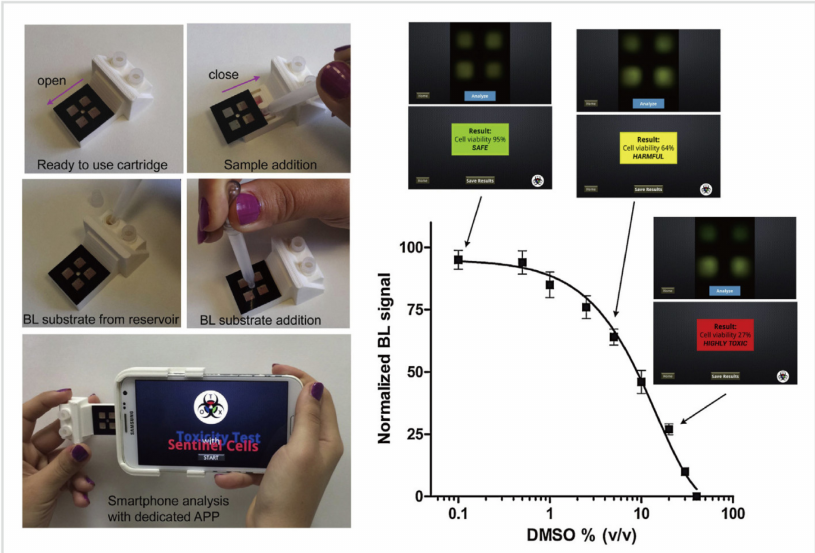
Figure 6. A smartphone-based bioluminescence (BL) whole-cell toxicity biosensor for on-field detection of toxicants; several easy steps required to carry out the toxicity test; dimethyl sulfoxide (DMSO) toxicity curve and the warming message (safe, harmful, or highly toxic) obtained with the smartphone-based biosensor and the Android application (Tox-App), set as “Safe” (cell viability: 100–80%), “Harmful” (79–30%), and “Highly toxic” ( < 30%) [138]. Copyright 2016,